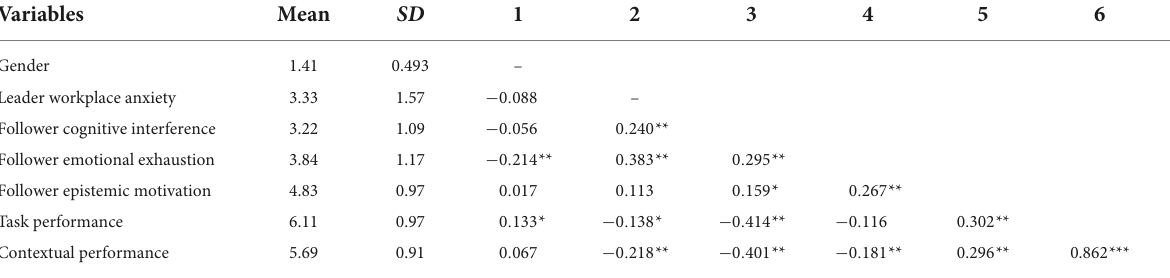
TABLE 1 Means, standard deviations, correlations, and reliabilities among studied variables.